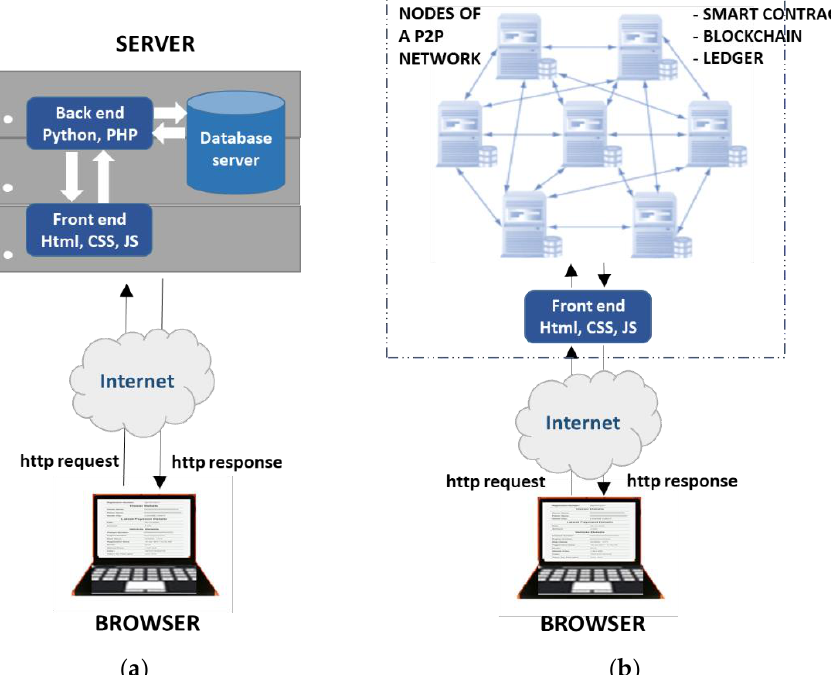
Figure 2. Workflow of ( a ) centralized web application versus ( b ) distributed web